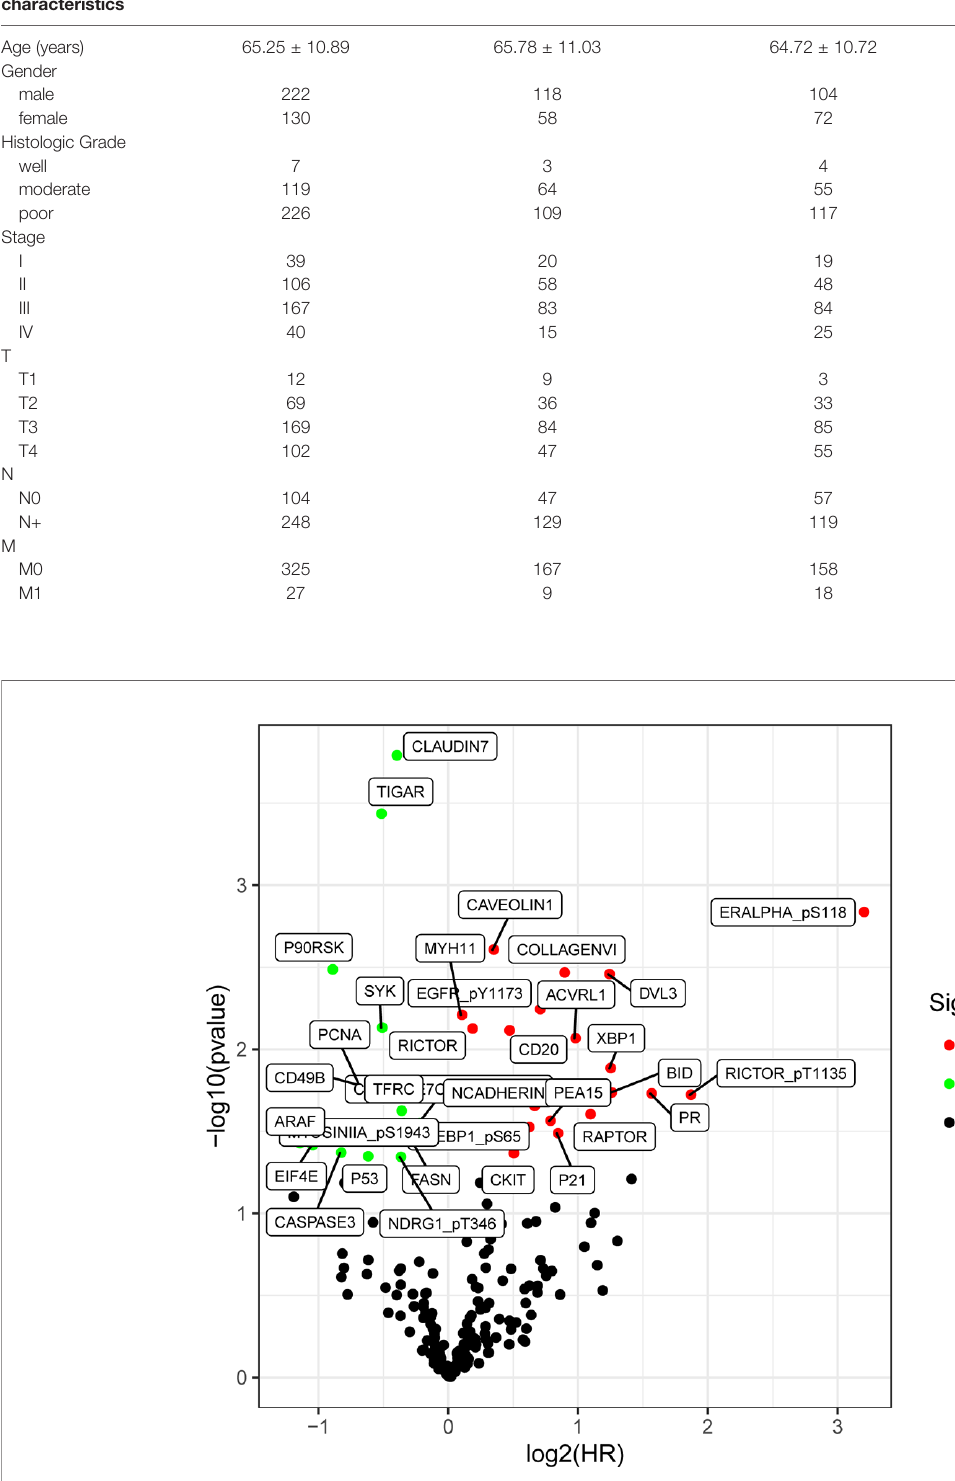
FIGURE 2 | Differential expression of proteins volcano map in gastric cancer. There is a difference in the expressions of up-regulated proteins (HR >1, P< 0.05) (highlighted in red), and down-regulated proteins (HR <1, P < 0.05) (highlighted in green).